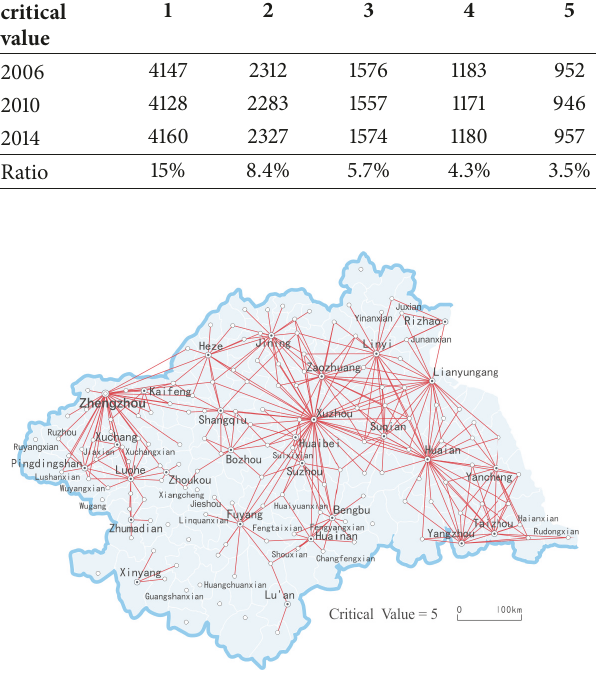
Figure 3: Urban network structure in 2014 (at the prefecture level or